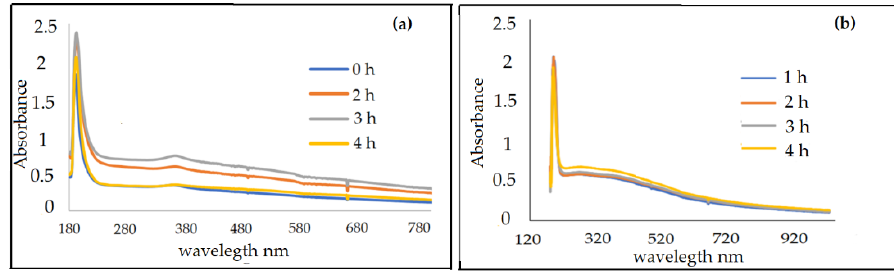
Figure 5. ( a ) UV–Vis spectra of ZnO NPs synthesis, as a function of time. ( b ) UV–Vis spectra of the synthesis of MnO NPs.